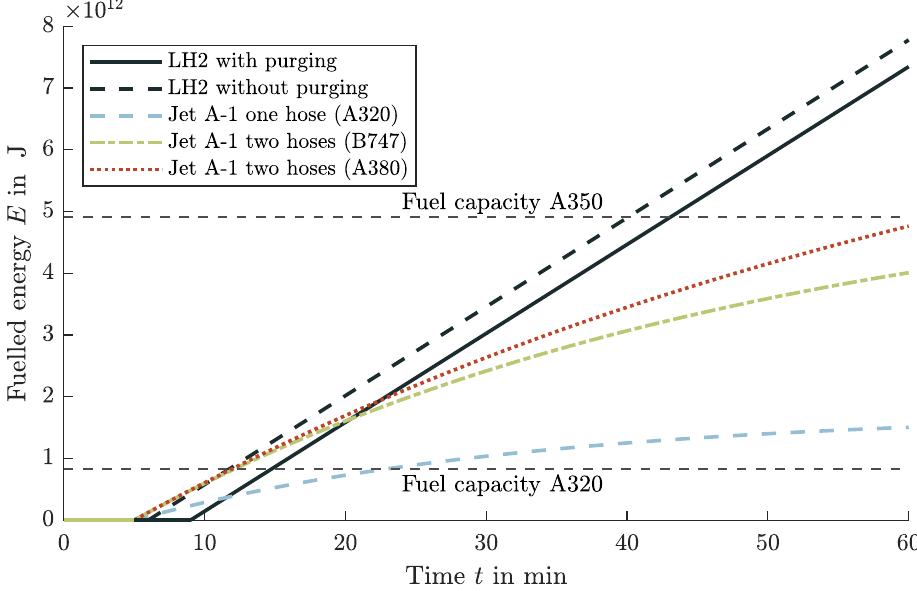
Figure 5. Refueling comparison between Jet A-1 and LH2; considering time influences before (purging, chill-down) and after (purging) the refueling process; for LH2 a constant mass flow of 20kg/s is applied; for Jet A-1 see Equation